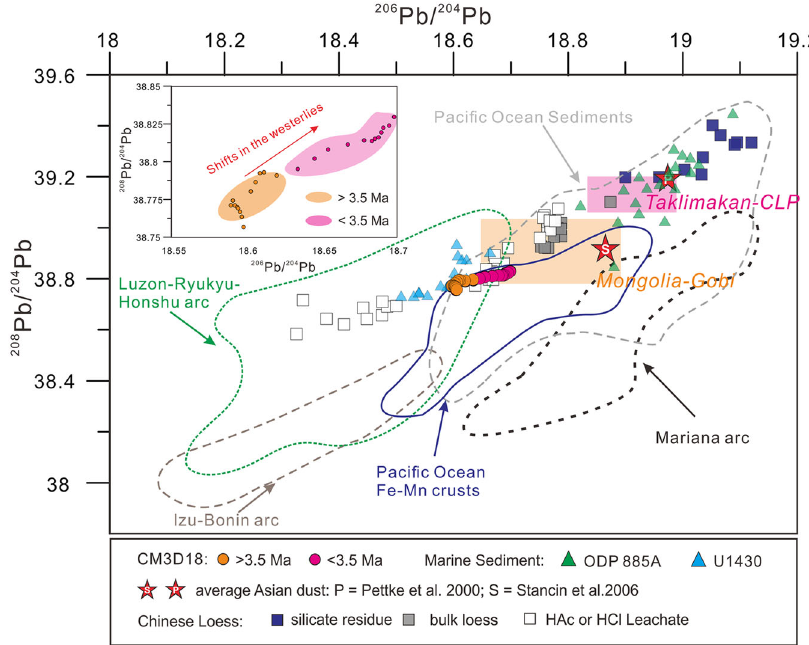
Fig. 2 Pb isotope data for Fe-Mn crust CM3D18 in comparison to other regional archives and input sources. Data sources: Paci fi c Ocean Fe-Mn crusts in the central NPO 16,25 – 28 ; Paci fi c Ocean detrital sediments 20,23,70 ; volcanic rocks of the Izu-Bonin arc, Mariana arc, and Luzon-Ryukyu-Honshu arc (compilations in Peate et al. 30 ); Chinese loess (bulk, residue, and leachates; refs. 16,20,71 ); marine detrital downcore sediments from IODP Site U1430 in the Sea of Japan 22 and ODP Site 885/886 in the North Paci fi c 23 . Stars represent estimates for the average pre-anthropogenic composition of Asian dust 23,72 , while typical compositions of the Chinese dust source areas are indicated for Mongolia-Gobi (orange-shaded box) and Taklimakan-CLP (pink- shaded box). Figure modi fi ed from Peate et al. 30 . Inset panel is an expanded view of the Pb isotope variations in Fe-Mn crust CM3D18 separated according to age (orange, before 3.5 Ma; pink, since 3.5 Ma), with the red arrow indicating the general trend through time towards the present (see also Supplementary Fig. 4g), which is interpreted to re fl ect shifts in the westerly